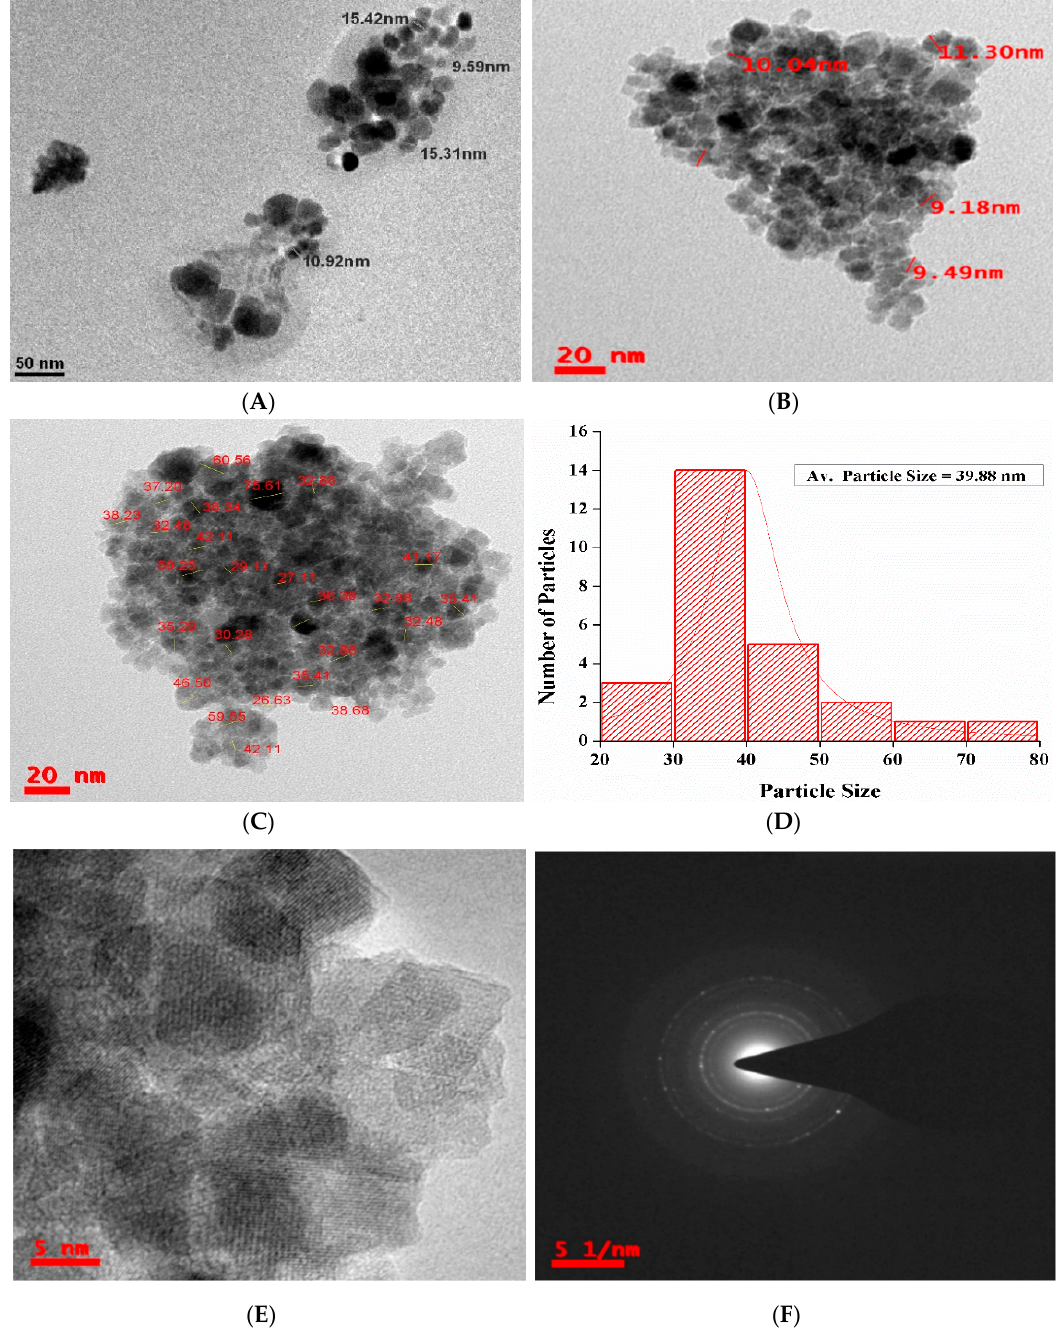
Figure 7. Transmission electron microscopy (TEM) and high-resolution TEM (HRTEM) micrographs of synthesized IONPs ( A – C ), histogram ( D ), D-spacing and lattice fringes ( E ) and SAED pattern ( F ).